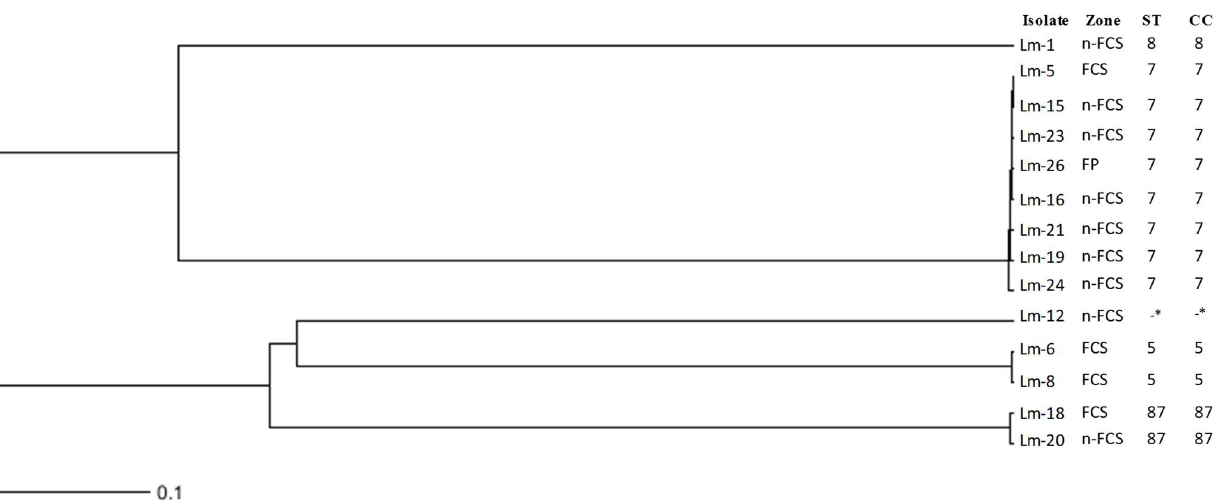
Table 4. Allelic distance detected among each pair of strains of the fourteen L. monocytogenes isolates.